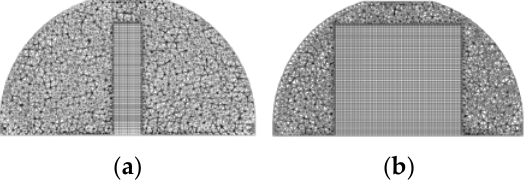
Figure 9. Mesh slices in the symmetry plane of the single-layer spherical recycling hood are shown: ( a ) xz plane; ( b ) yz plane.